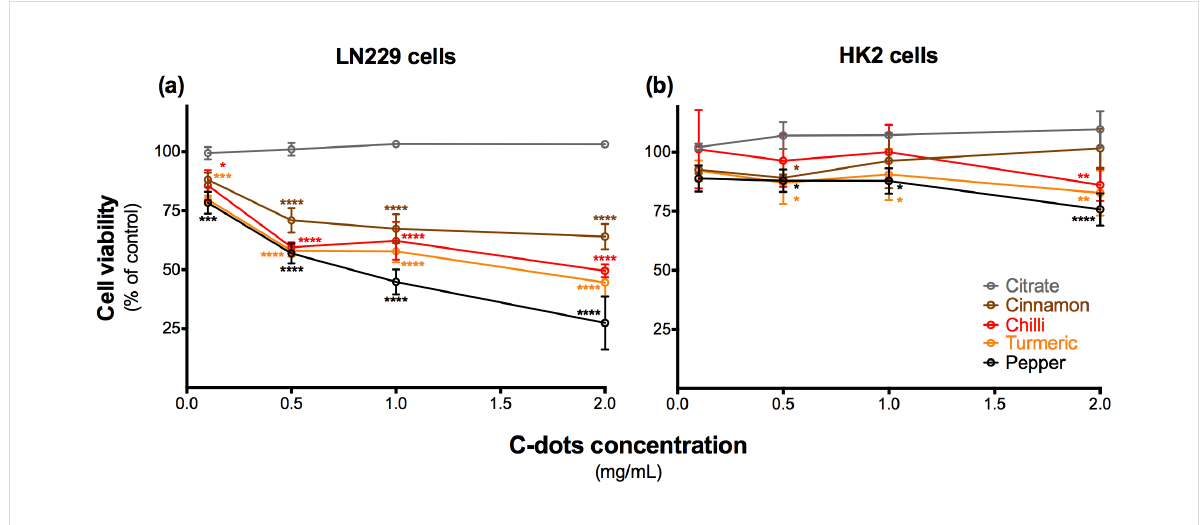
Figure 8: Cell viability evaluation (PrestoBlue) after 24 h of incubation with increasing concentrations of each type of C-dots. After exposing both LN-229 and HK-2 cells, the ability of these cells to metabolize resazurin to resofurin was tested as a measure of cell viability. Results are means ± SD of at least three independent experiments. * p < 0.05, ** p < 0.01, *** p < 0.001 and **** p < 0.0001 for statistical significance of differences between the same concentration of citric acid-derived and each of the food-derived